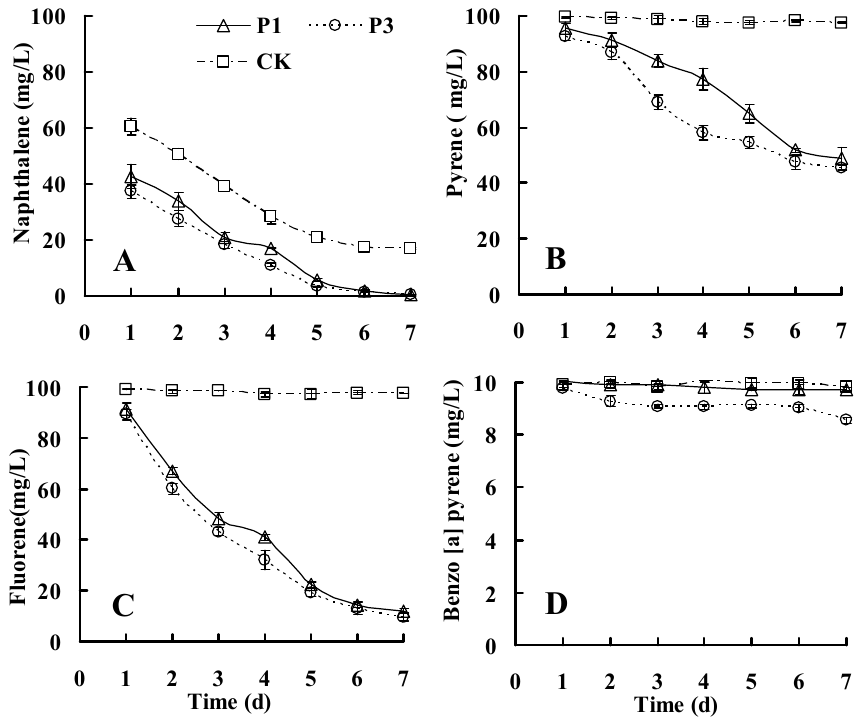
Figure 4. Degradation of NAP ( A ); PYR ( B ); FLR ( C ); and B(a)P ( D ). The strains were grown in MS medium containing single PAHs.